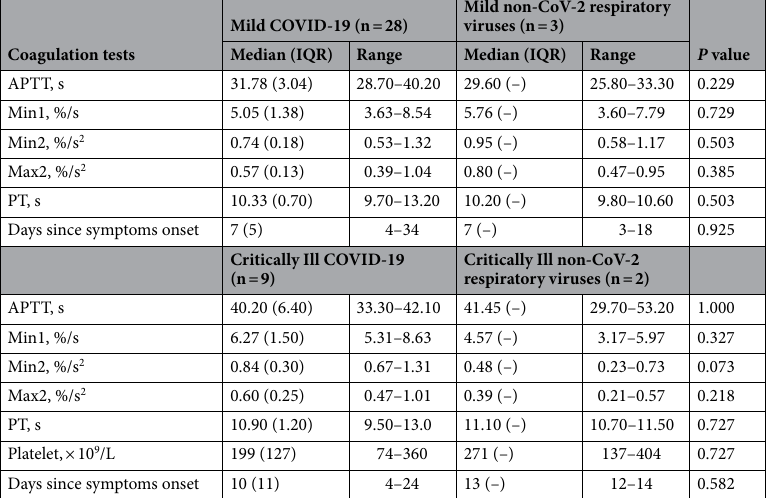
Paired analysis data, available in a limited number of subjects, comparing intra-individual CWA fluctuations before and after clinical deterioration demonstrated distinct pattern of change between COVID-19 and non-